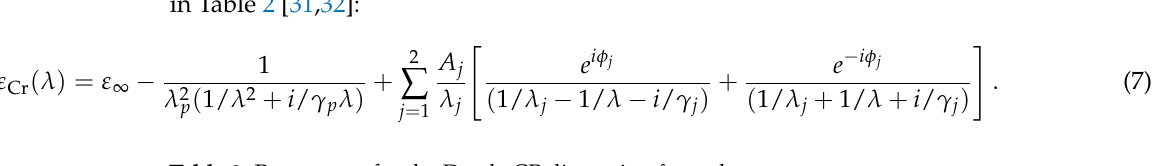
Table 2. Parameters for the Drude CP dispersion